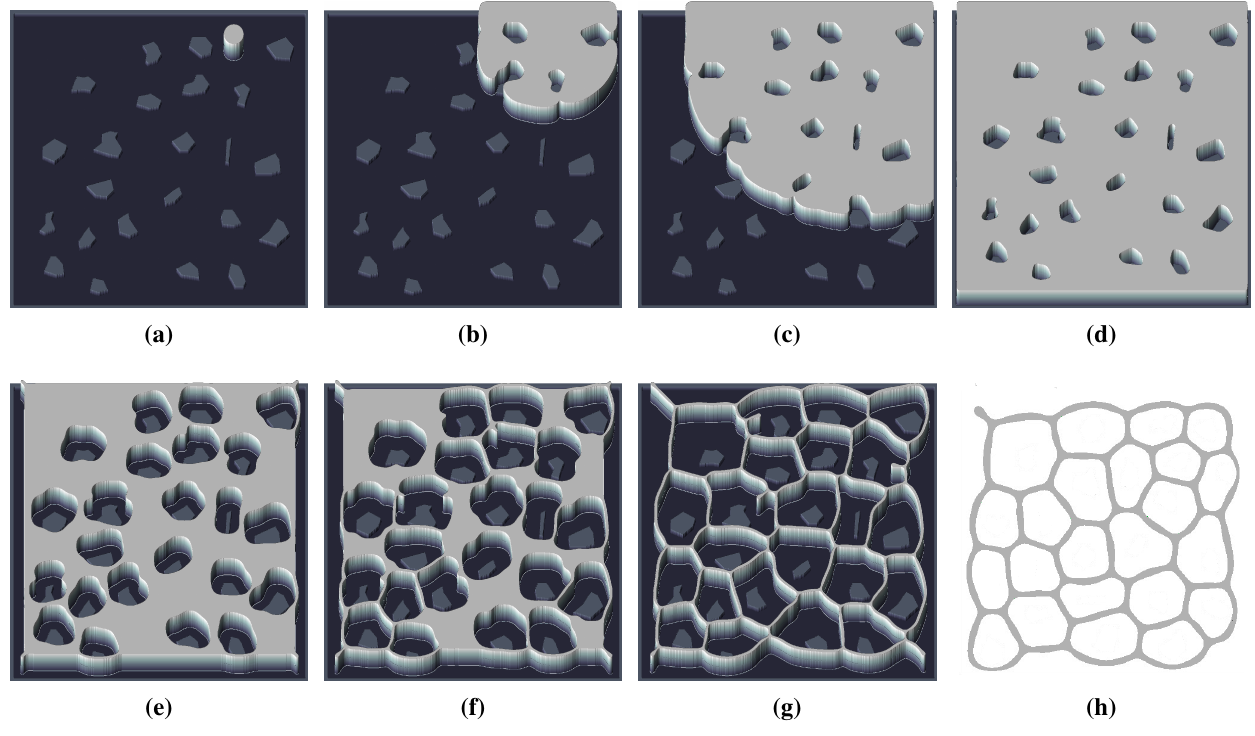
Figure 5. Steps of the RD-based Voronoi algorithm applied to the potholes environment: ( a – d ) expansion phase, a wavefront using the fluid-like behaviour evolves over the integration domain; ( e – h ) contraction phases, the resulting concentration profile of the previous stage evolves till generating a VD of the